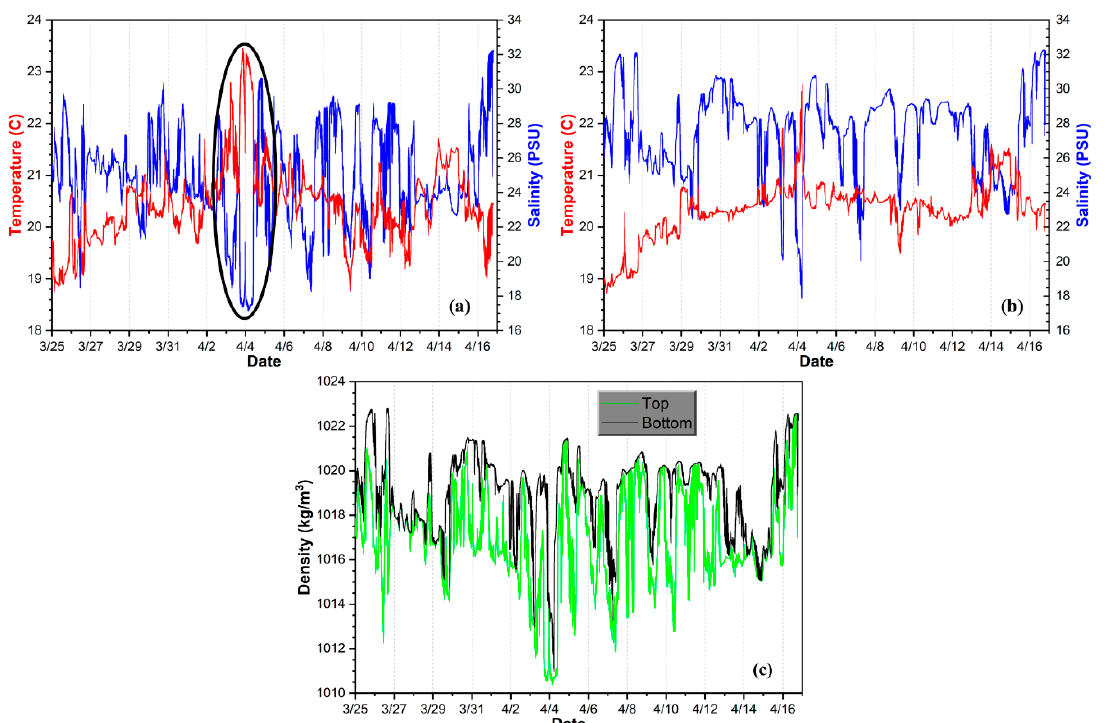
Figure 7. ( a ) Temperature and salinity, LM3 top (black oval denotes a warm, low salinity pulse followed by a temperature decrease and a salinity increase, as described in the text); ( b ) Temperature and salinity, LM3 bottom; ( c ) Density, LM3, top and bottom.